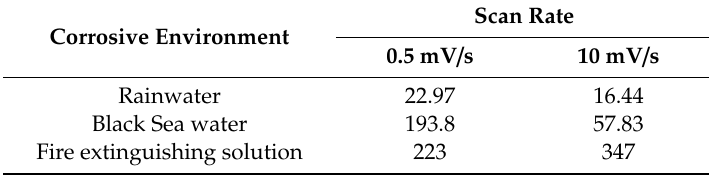
Table 8. Comparison between corrosion rates (v cor -in µ m / year) for the I-Zn sample.